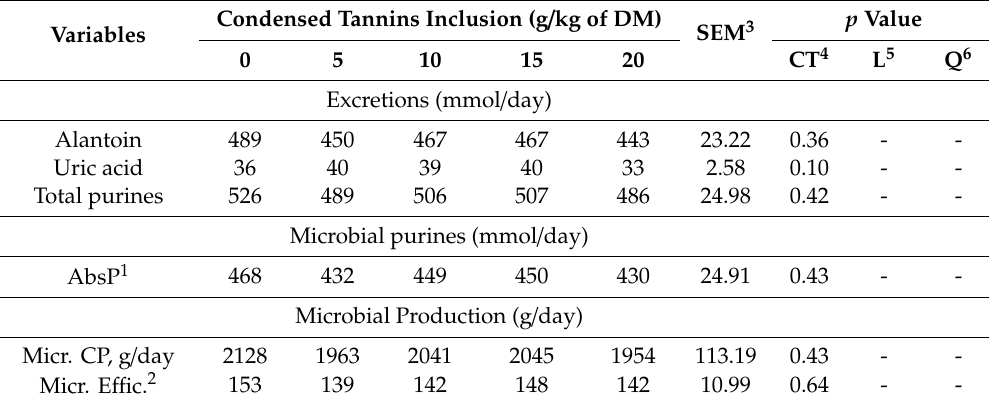
Table 5. Ruminal microbial protein synthesis of Holstein cows fed diets with five levels of condensed tannins from Acacia